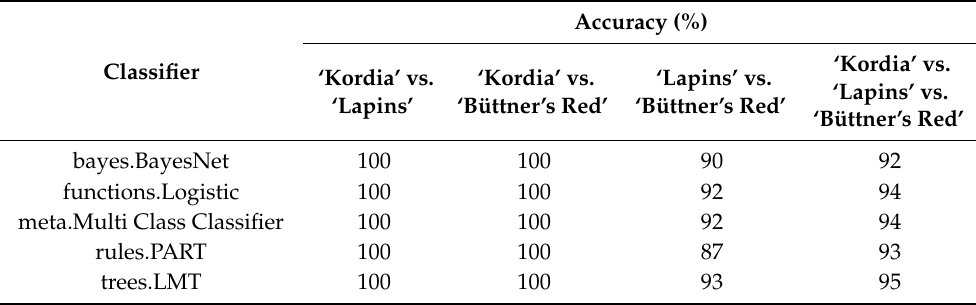
trees.LMT 100 93